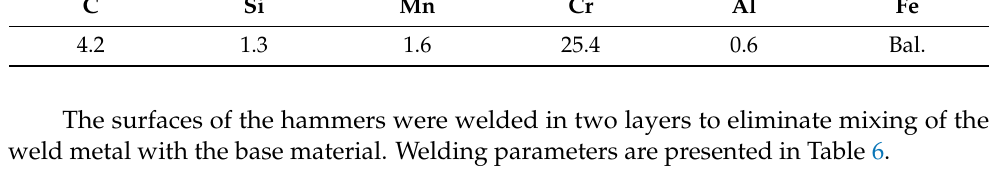
Table 6. Used welding